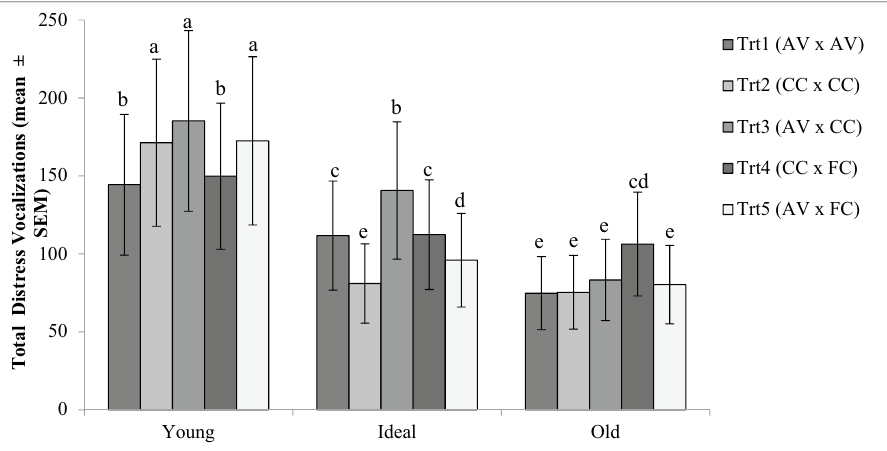
Figure 3. Social isolation test. LSMean ± SEM values for total distress vocalizations during 5-min sessions, for Experiment 1 progeny from the different Maternal Rearing × Adult Housing treatments, and from three maternal ages tested at 5 days of age. Behavioral differences are indicated by different superscripts (P < 0.001 a–e ).